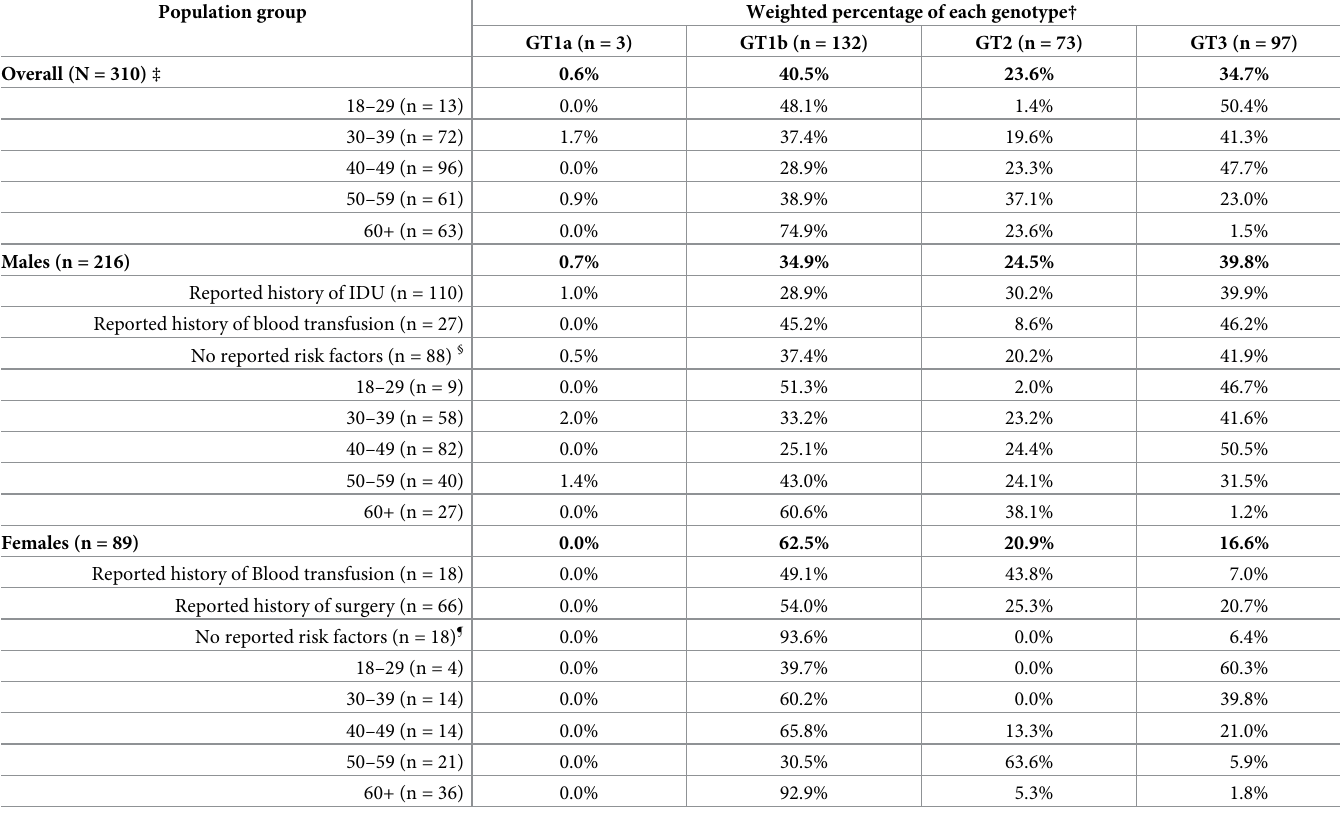
Table 2. HCV genotype distribution by sex and reported risk factors, Georgia HCV serosurvey, 2015. Population group